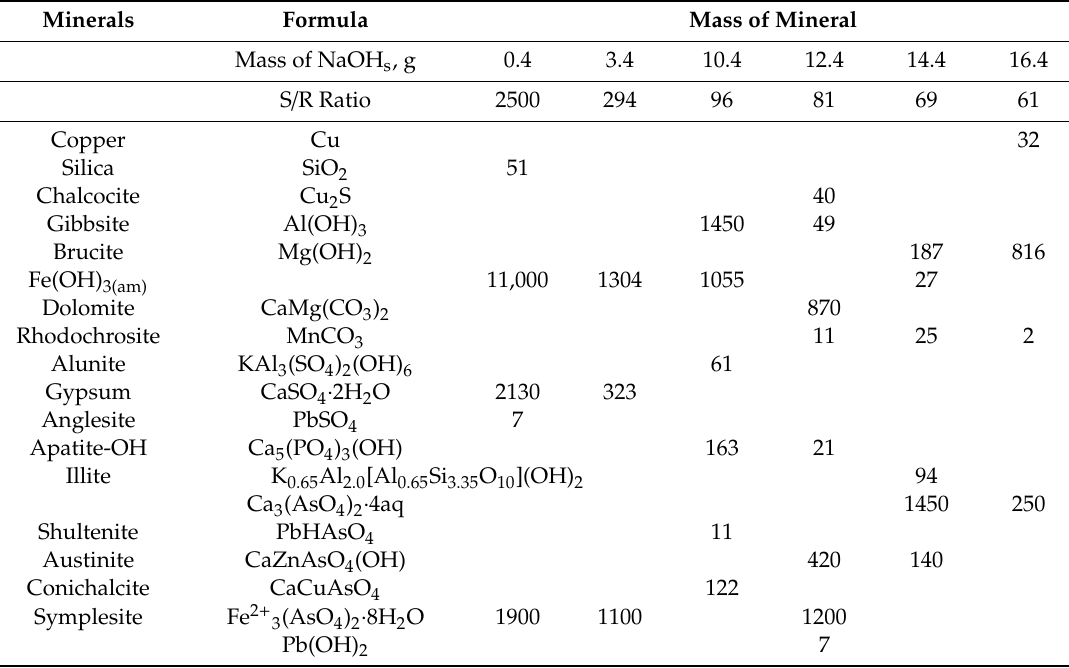
Table 8. Model quantity of the precipitated minerals, mg (numerical simulation for NaOH